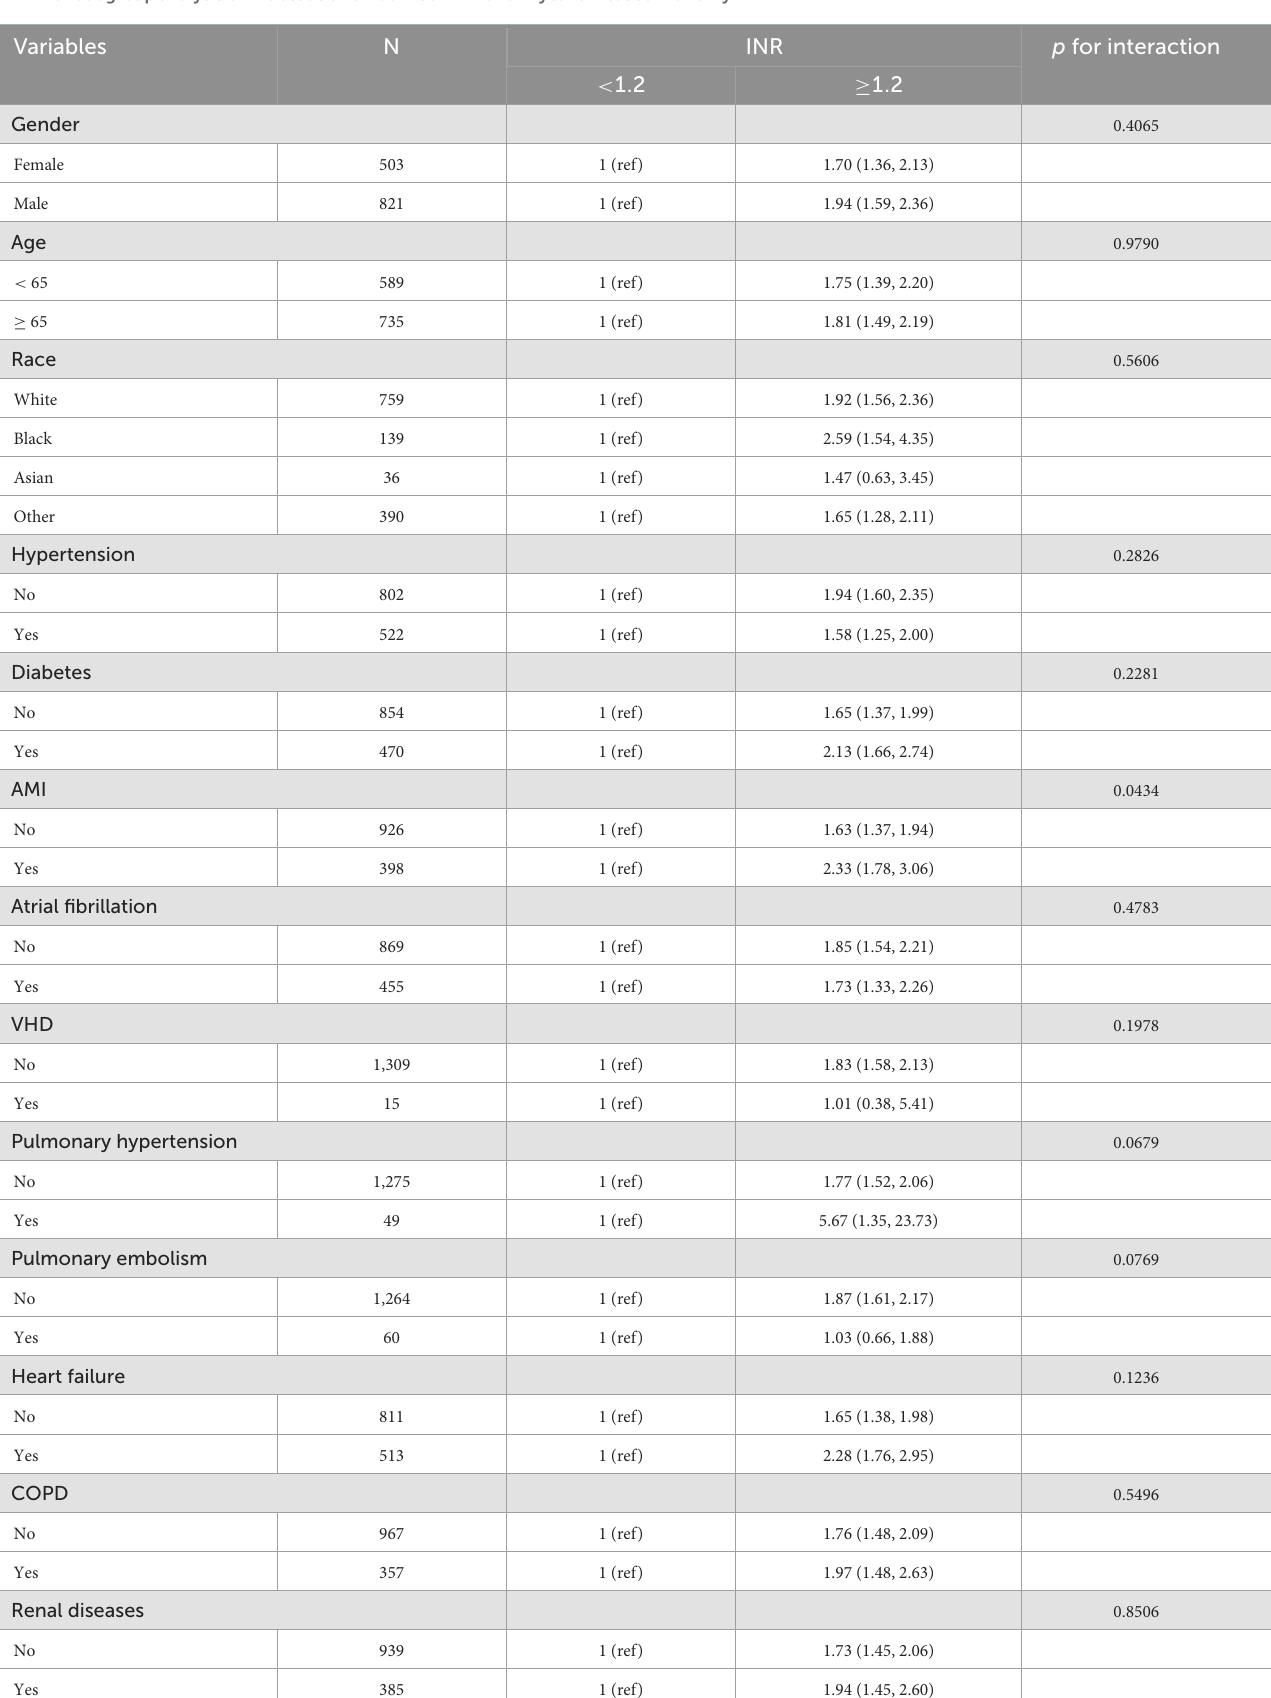
TABLE 3 Subgroup analysis of the association between INR and 1-year all-cause mortality. Variables N